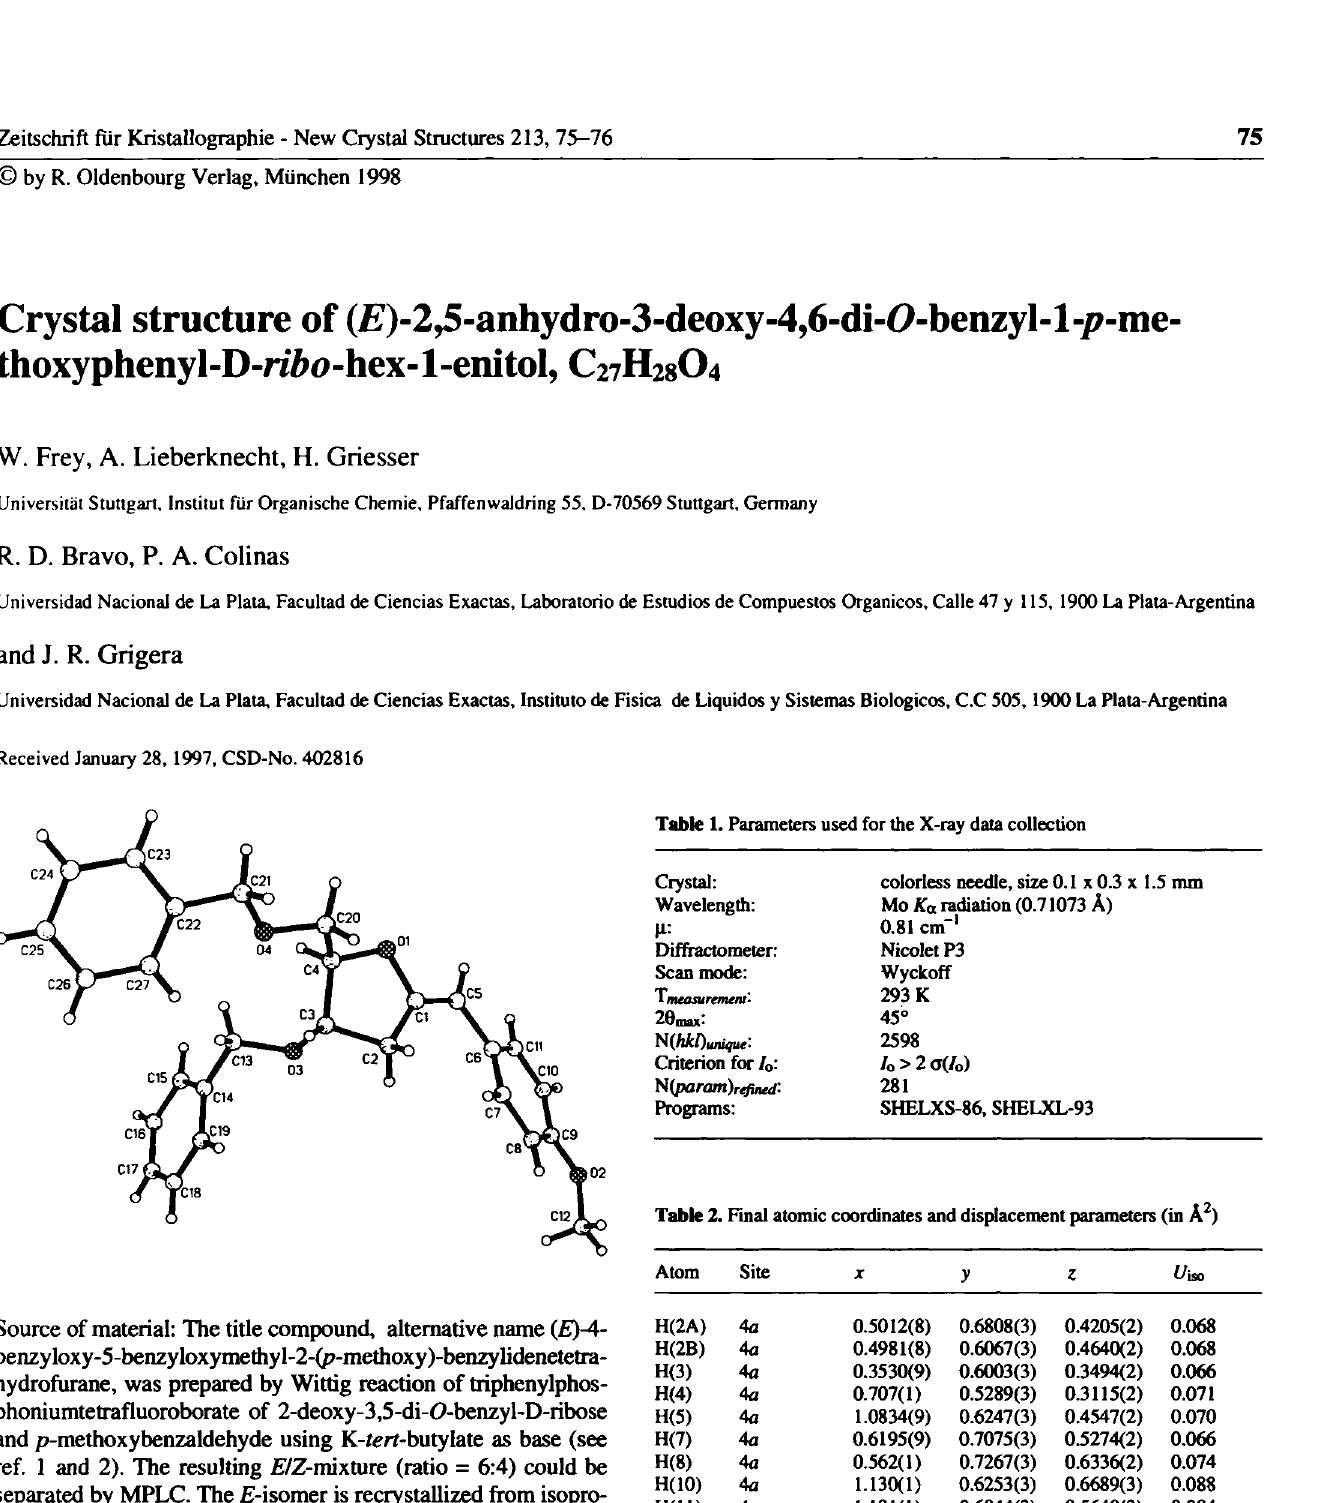
Table 2. Fmal atomic coordinates and displacement parameters (in